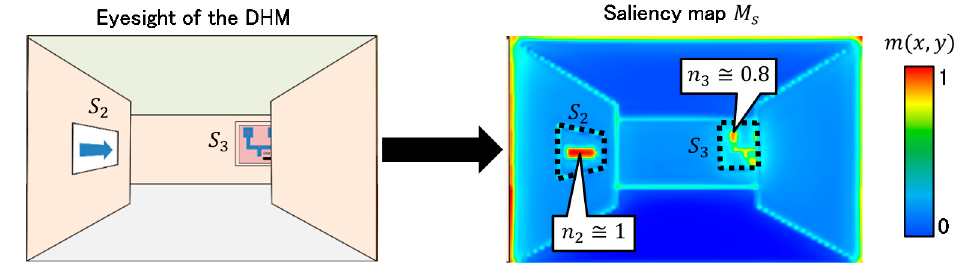
Figure 6. Signage noticeability estimation.